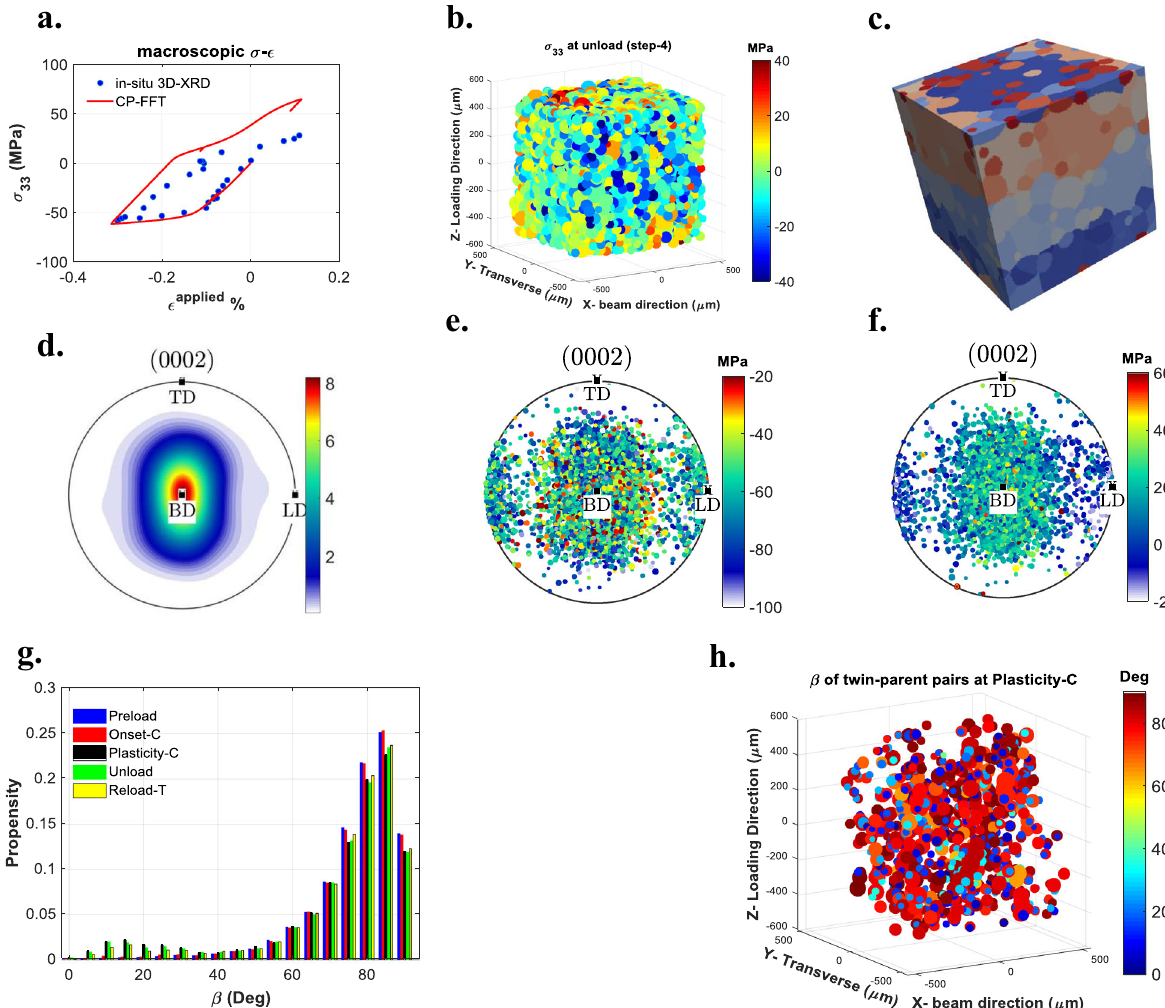
Fig. 1 An overview of the results for Mg-1. ( a ) Measured and calculated macroscopic stress – strain curve, ( b ) measured 3D grain map and stress in the loading direction at the unload step, ( c ) reconstructed 3D grain map for CP-FFT modelling. The measured (0002) pole fi gures at ( d ) Preload, ( e ) Plasticity- C, and ( f ) Reload-T steps. In ( e ) and ( f ) grains are colour coded with respect to their stresses in the loading direction (LD) and the size of each circle is proportional to the measured relative volume for the grain. ( g ) The measured distribution of β at each loading step. β is the misorientation between the basal plane normal of each indexed crystal and the loading direction. ( h ) A 3D view of the matched twin-parent pairs at the Plasticity-C step. Grains are colour coded with respect to their β